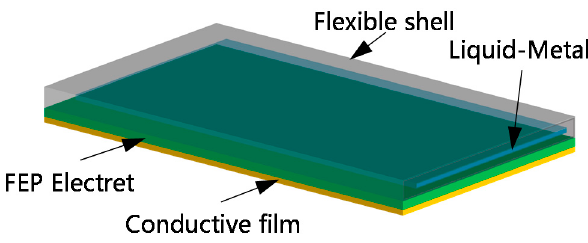
Figure 1. Structure of the flexible and stretchable energy harvester based on gallium liquid-metal alloy.